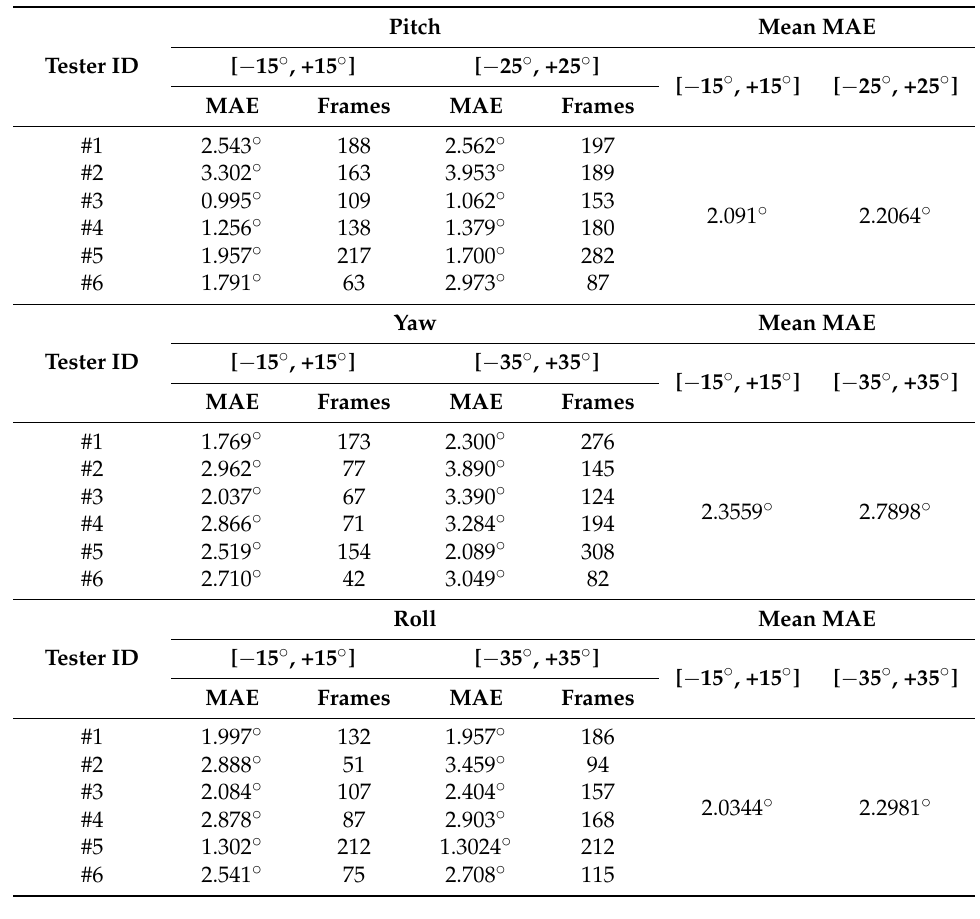
Table 2. Mean absolute error of head pose estimation for different